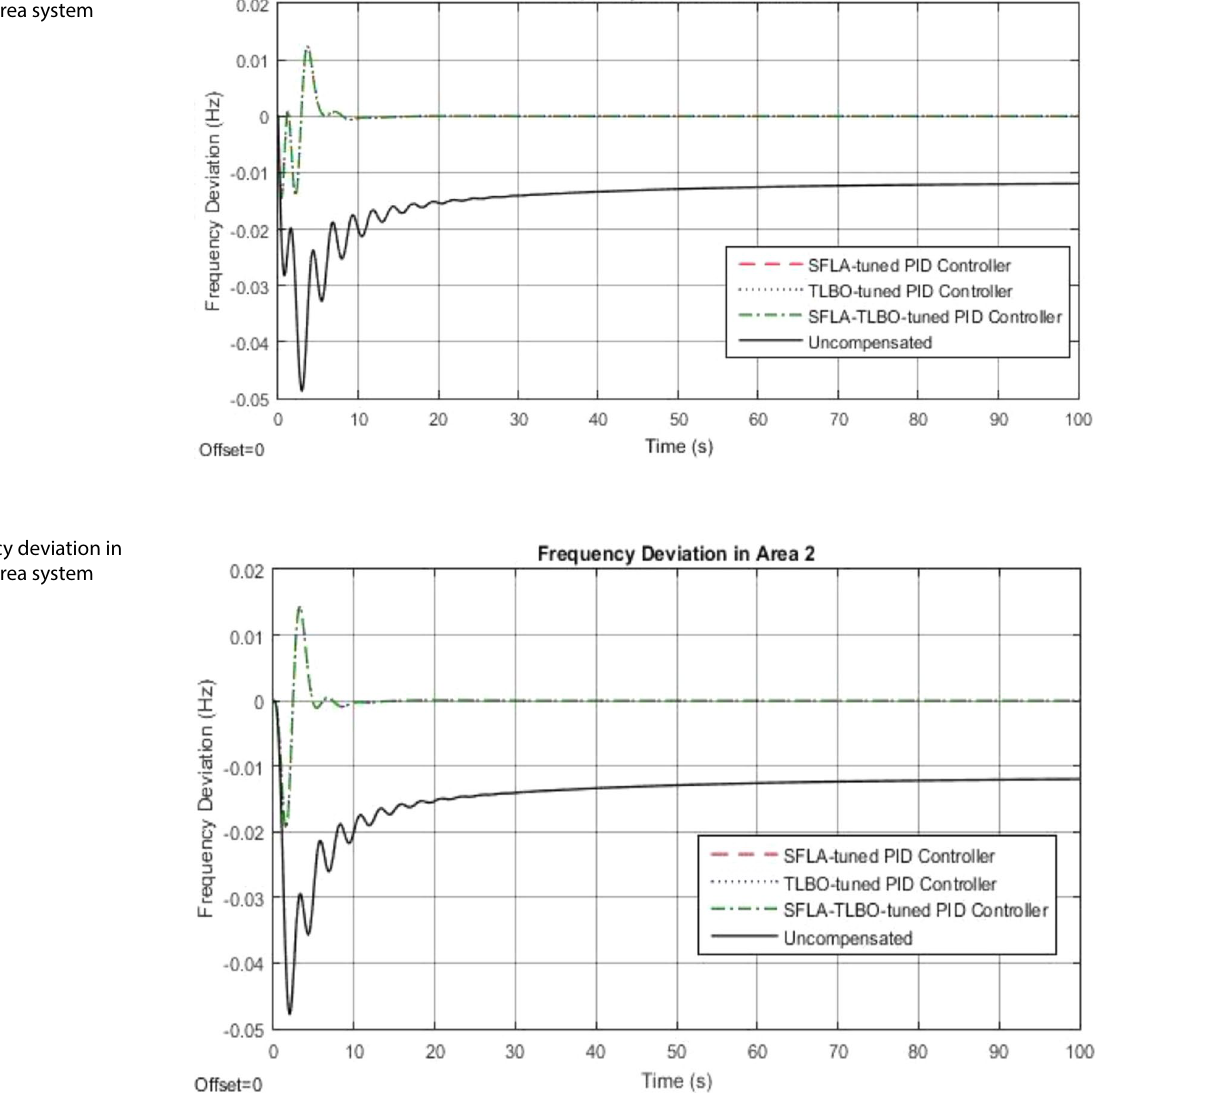
Fig. 7 Frequency deviation in area 1 for two-area system